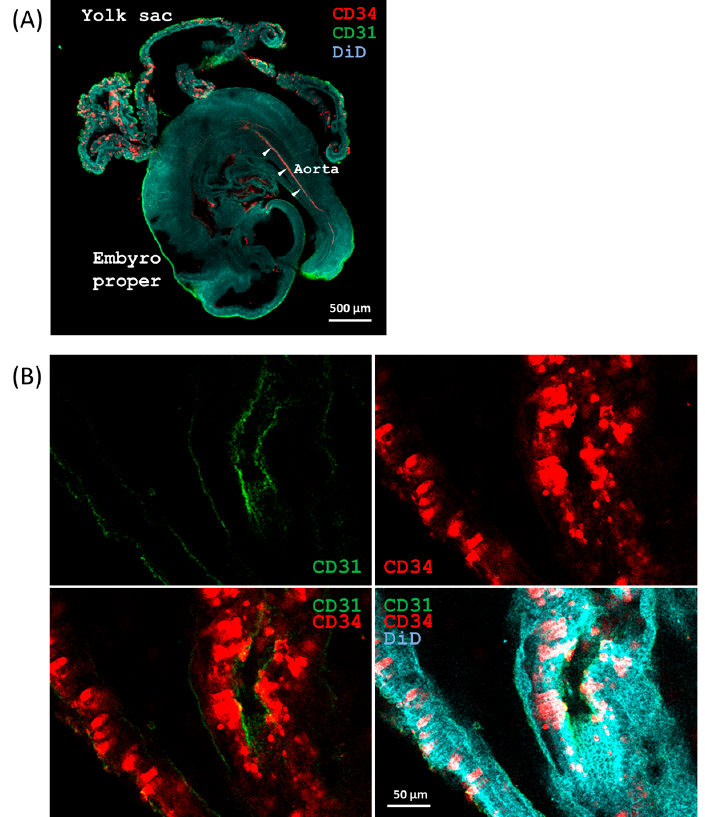
Figure 2. Whole mount immunofluorescence staining of an E10 murine yolk sac and embryo. ( A ) A set of E10 yolk sacs and embryo proper were whole mount stained with CD31 and CD34 antibodies to locate the vascular endothelia and HECs. The ventral side of the aorta which was revealed by the line of CD34 signal, is indicated by arrow heads. ( B ) Image of the yolk sac with higher magnification performed to unveil the rectangular and round shapes of CD34 + cells which were present in CD31 de fi ned tubular structures in the yolk sac.